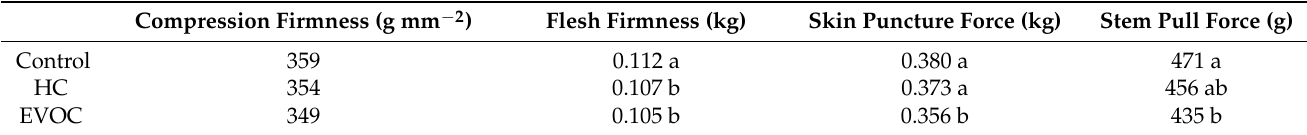
Table 8. Effect of dormancy-breaking agents on the post-harvest fruit firmness and stem pull force of the sweet cherry cultivar ‘Lapins’ following 6 weeks cool storage. HC = hydrogen cyanamide; EVOC = emulsified vegetable oil